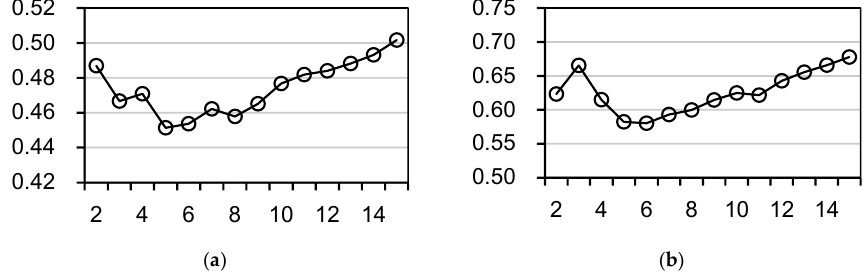
Figure 1. Variation of the coefficients of variation index with the number of clusters. The left side shows the result of the equal division of the trajectory method, and the right side is the result for the mass moment of the trajectory method. ( a ) Equal division of the trajectory method. ( b ) Mass moment of the trajectory method.